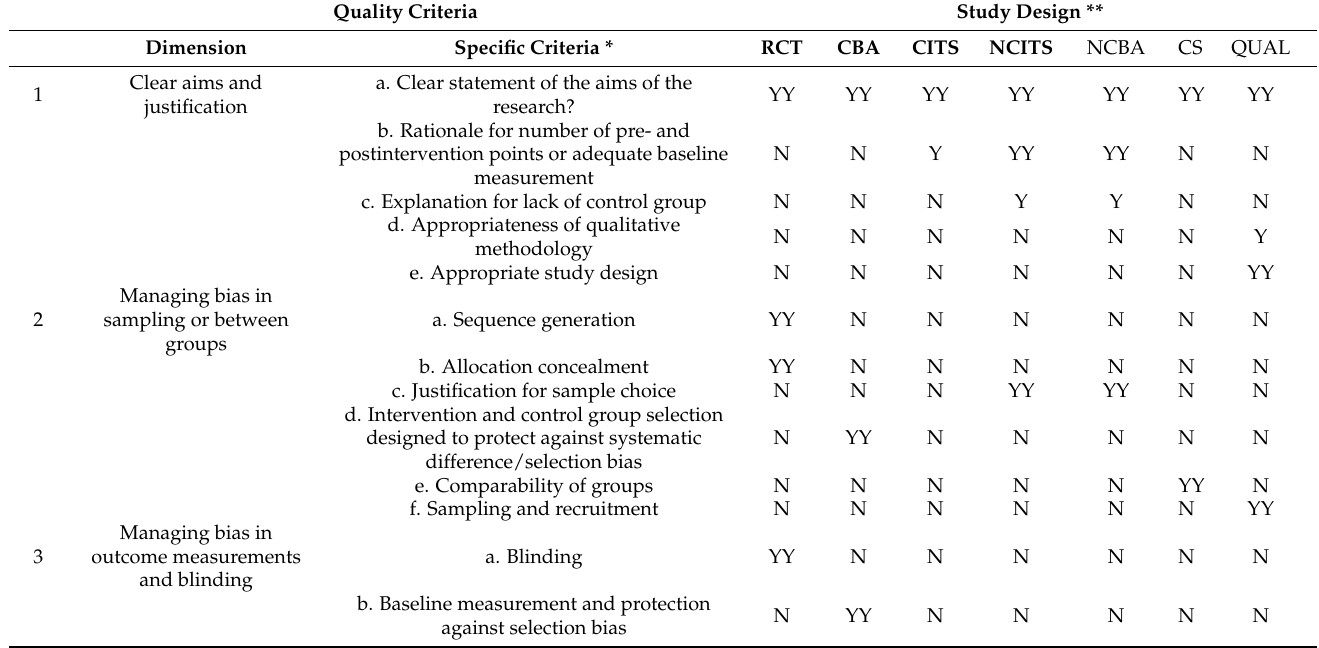
Table A2. ICROMS Quality Criteria for Application per Study